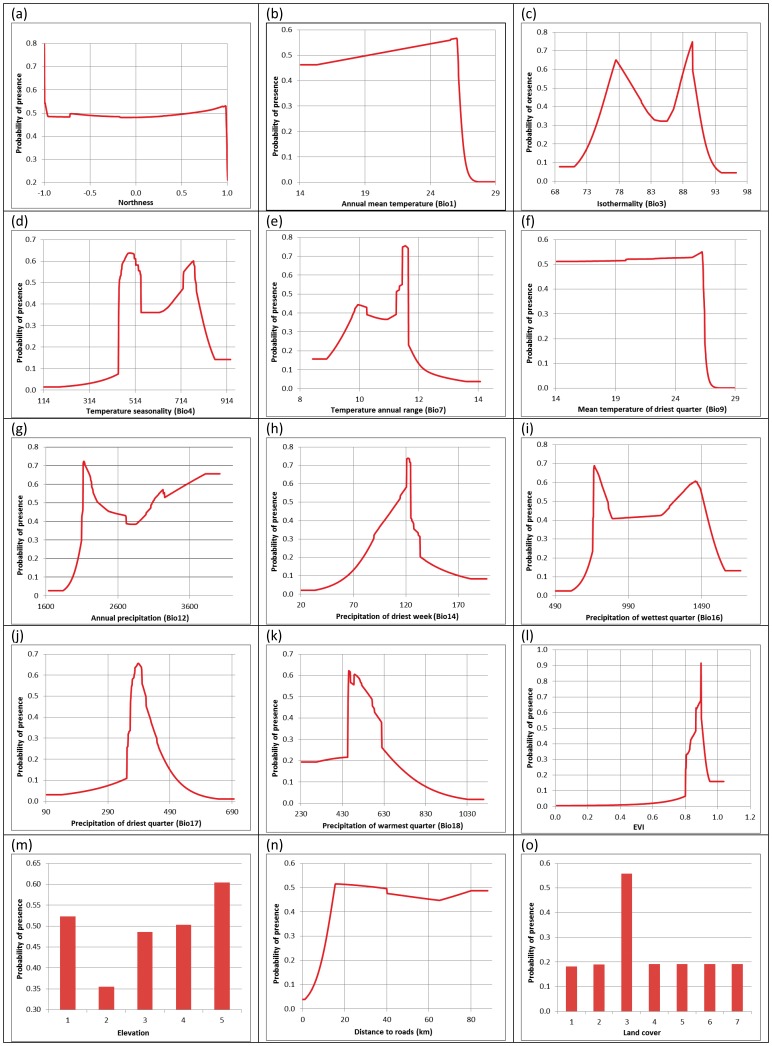
Variable response curves for the predictors of the MaxEnt model.These plots show the dependence of predicted suitability on selected variable and the dependencies with other variables.